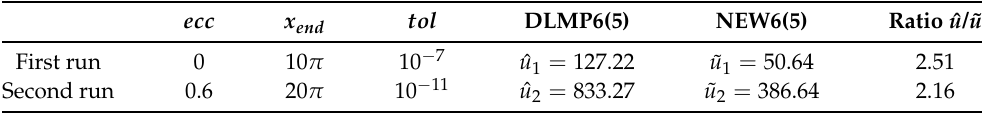
Table 1. Efficiency measures for both runs and